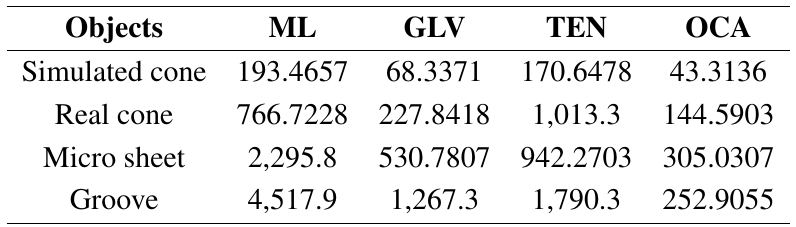
Table 5. Surface smoothness comparison of various focus measures